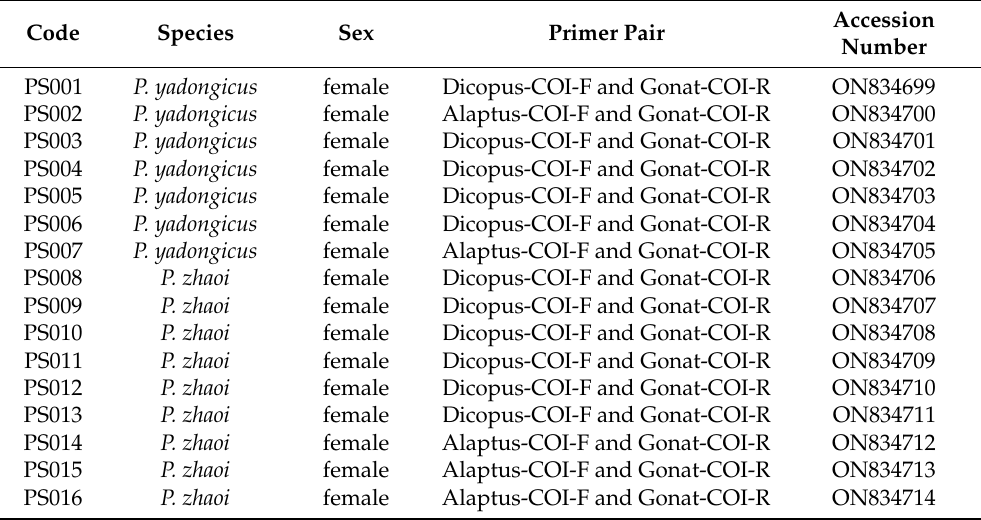
Table 1. Information on sequenced specimens with GenBank accession number of COI.